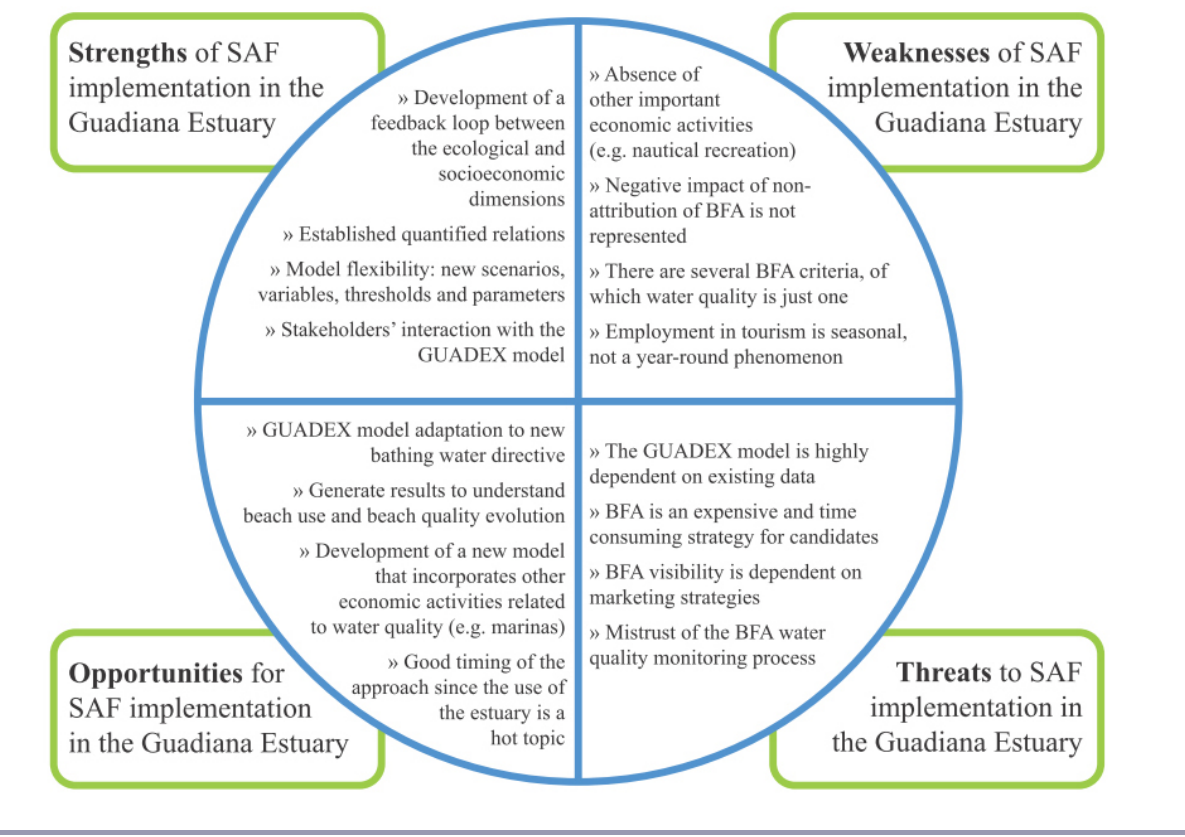
Fig. 8 . Qualitative information obtained during bilateral meetings where SAF implementation was summarized and GUADEX was presented to stakeholders.